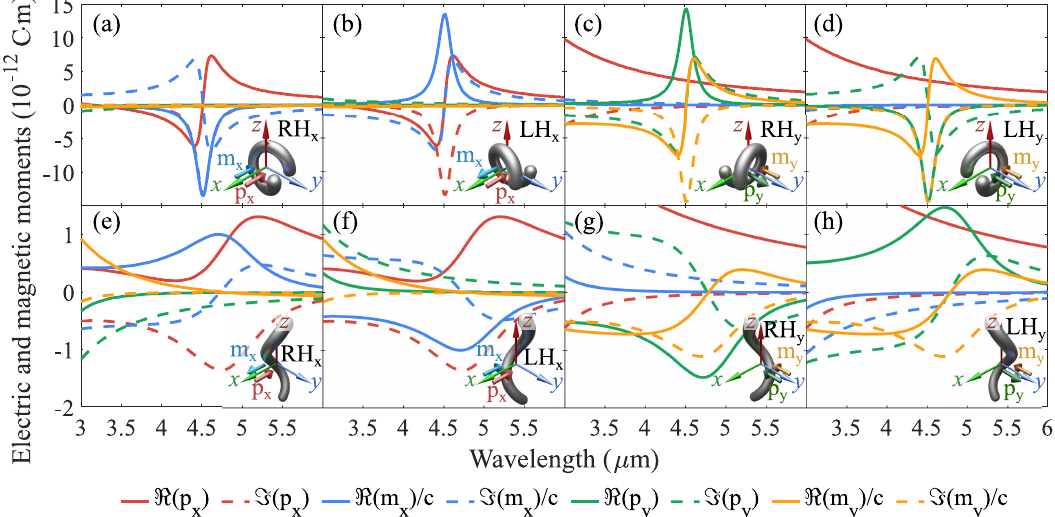
Figure 2. The wavelength dependence of the real and imaginary parts of individual electric and magnetic dipole moments under the different orientation of RH and LH ( a – d ) horizontally oriented helices and ( e – h ) vertically oriented helices. The helices are illuminated by the linearly polarized incident plane wave propagating along the − z -direction with the polarization state (3). The orientation of helices with main induced dipole moments are shown in the inset of each plot. The designations RH x,y and LH x,y mean that the helix with RH or LH handednesses is oriented along the x , y -axes relative to the plane of the metasurface.